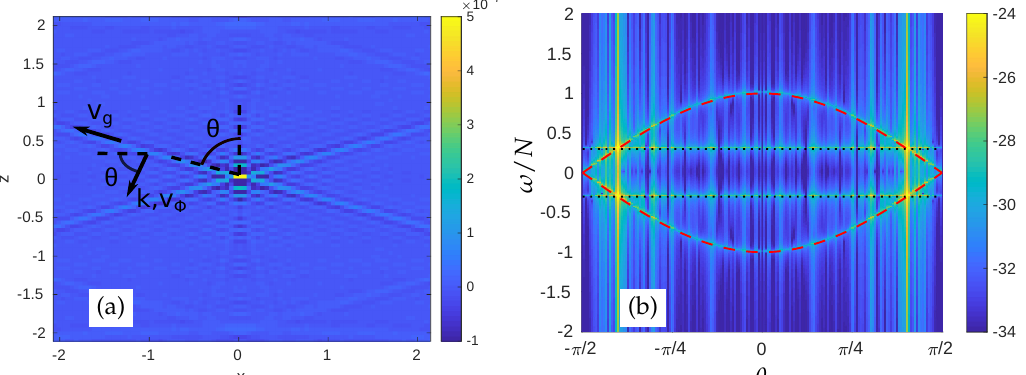
Figure 3. ( a ) Distribution of vertical velocity component u z showing the Saint Andrew’s cross pattern of propagation of waves in the ( x , z ) plane in physical domain (zoomed in, the complete resolution domain is [ − π , π ] 3 ) for a simulation with a resolution n = 128 grid points in each direction, and stratification frequency N = 1. The group velocity v g , phase velocity v Φ and wavevector k are also represented. ( b ) The corresponding concentration of energy density E ( θ , ω ) in the ( θ , ω ) Fourier domain (in log scale). Red dashed line: dispersion relation curve ω r ( θ ) for internal gravity waves defined by Equation (2). Black dotted line: forcing frequency ω f